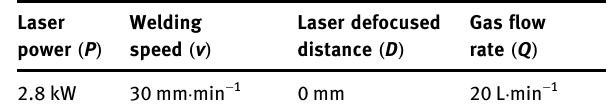
Table 2: Parameters of laser welding